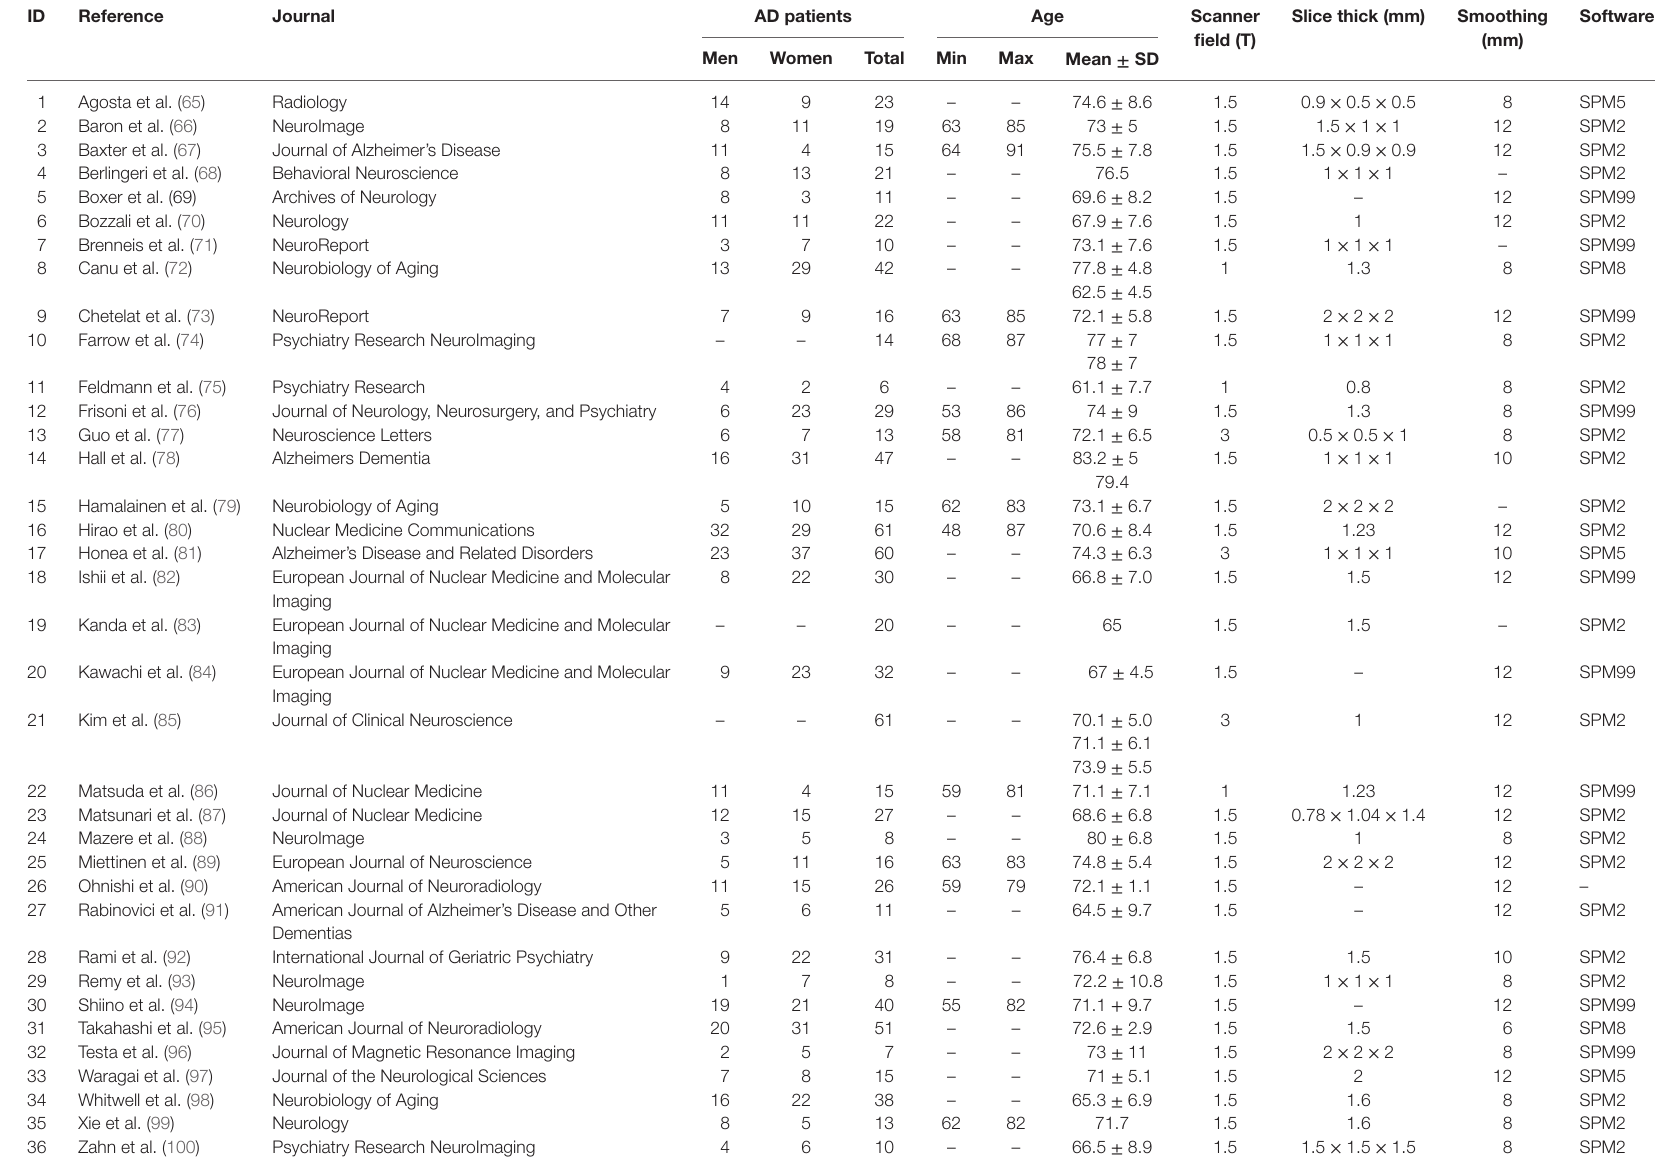
Table 1 | Selected studies for the